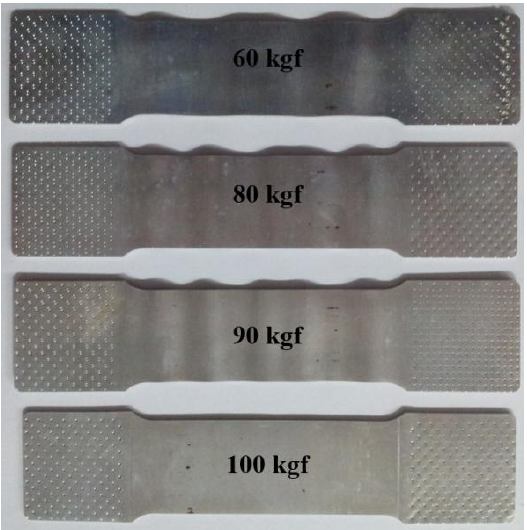
Figure 4. Buckling of specimen at low values of side